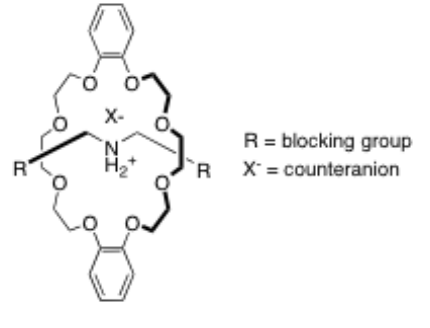
Figure 2. Ammonium-crown ether-based rotaxane.